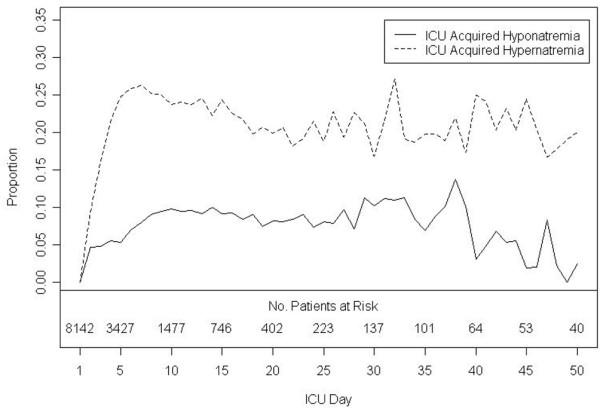
Proportion of intensive care unit (ICU) patients with serum sodium values outside the normal range during the first 50 days of ICU stay*.